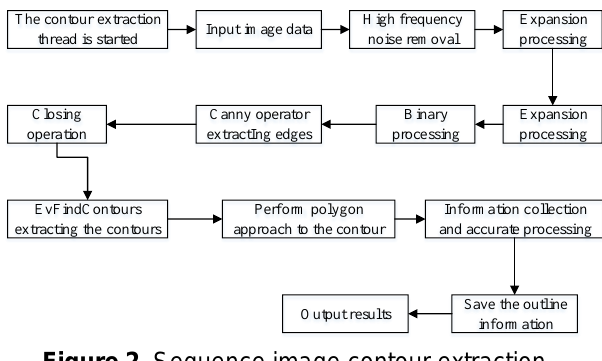
Figure 2. Sequence image contour extraction algorithm process